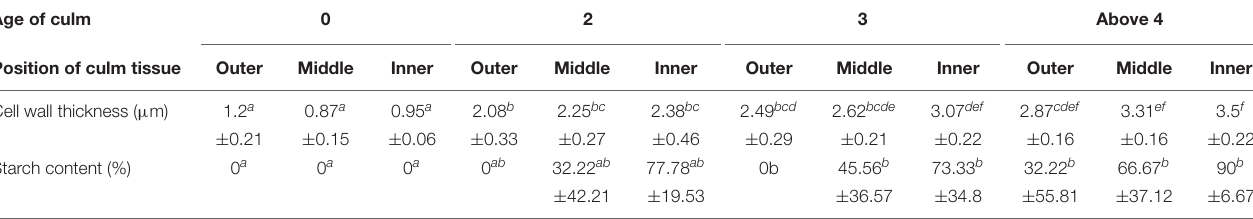
FIGURE 4 | Horizontal sections of culm tissue from four different age groups stained with Coomassie blue and Iodine [ (A) : 0-year-old (current year), (B) : 2-year-old, (C) : 3-year-old, (D) : above 4-year-old]. All images are from the middle portion of the culm section. The cell wall thickness of the parenchyma cells changes significantly in the first 2 years. Starch granules are stained dark purple inside the cell are only present in older culms. TABLE 1 | Age variation of cell wall thickness ( µ m) and starch content (%) of parenchyma cells in culm tissue.